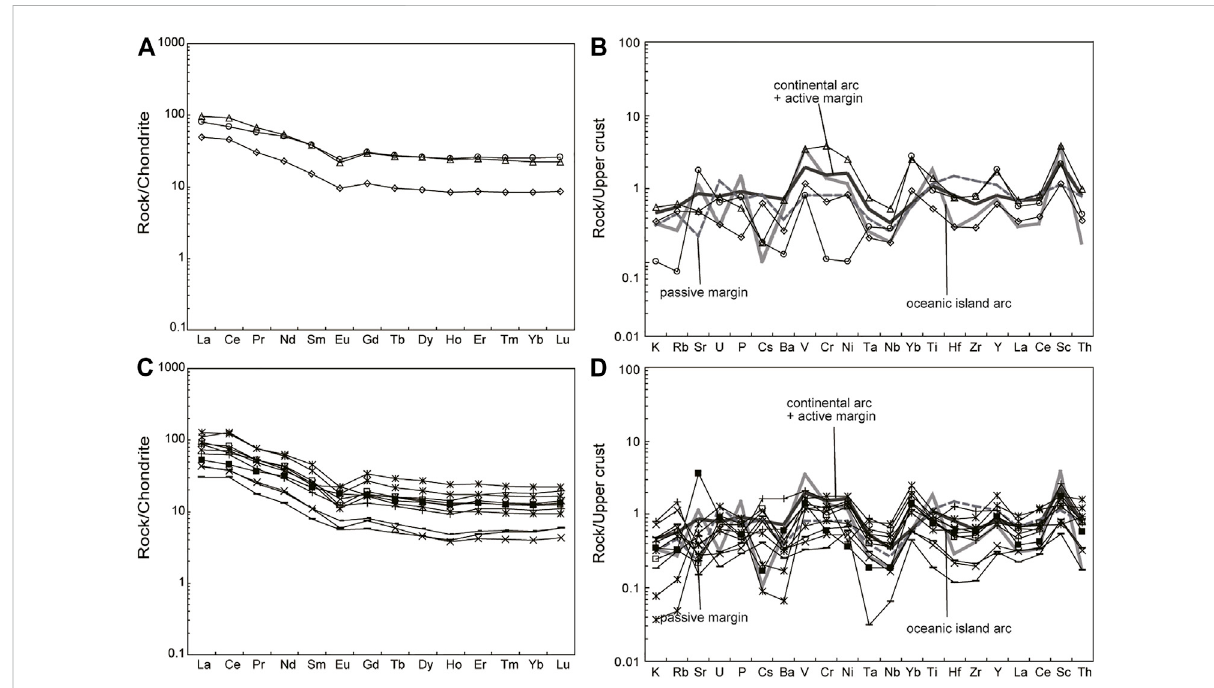
FIGURE 10 Chondrite-normalized REE diagram and multielement diagrams normalized to average upper continental crustal values (Floyd et al., 1991). (A) and (B) are the sandstone samples of the north KGSC in HL area, (C) and (D) are the sandstone samples of the south KGSC in HL area. The chondrite values are from a previous study (Boynton, 1984). The cited passive margin, oceanic island arc and continental arc island arc+ active continental margin values are from Floyd et al. (1991). The symbols used are the same as those used in Figure